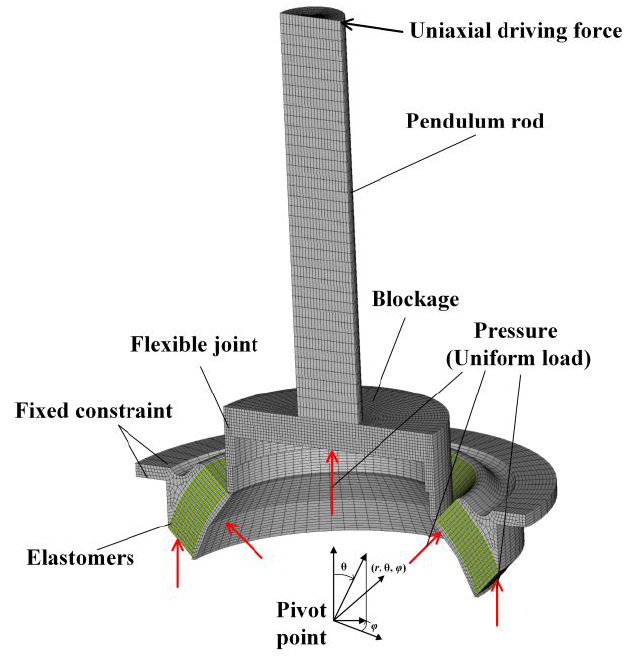
Figure 10. FE Model of the flexible joint in fatigue test.